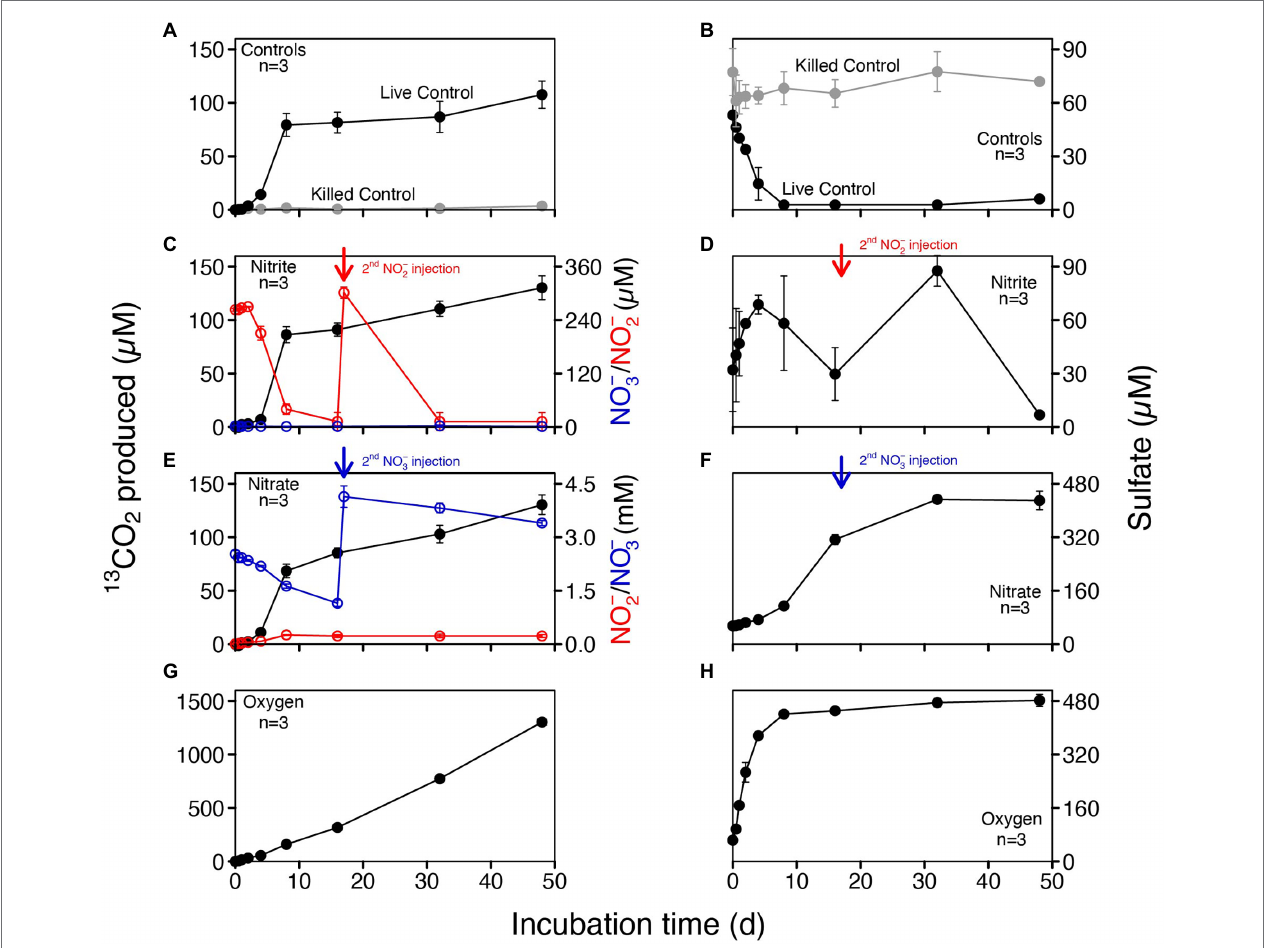
FIGURE 3 | Concentrations of produced 13 CO 2 and sulfate in anoxic slurries amended with 13 C-labeled methane and different electron acceptors (nitrite, nitrate and oxygen). (A,B) Controls including killed controls (autoclaved) and live controls (without electron acceptors added). (C,D) Nitrite addition; nitrite was replenished after 17 days. (E,F) Nitrate addition; nitrate was replenished after 17 days. (G,H) Oxic incubations. No nitrite and nitrate were detected in both controls and slurries with